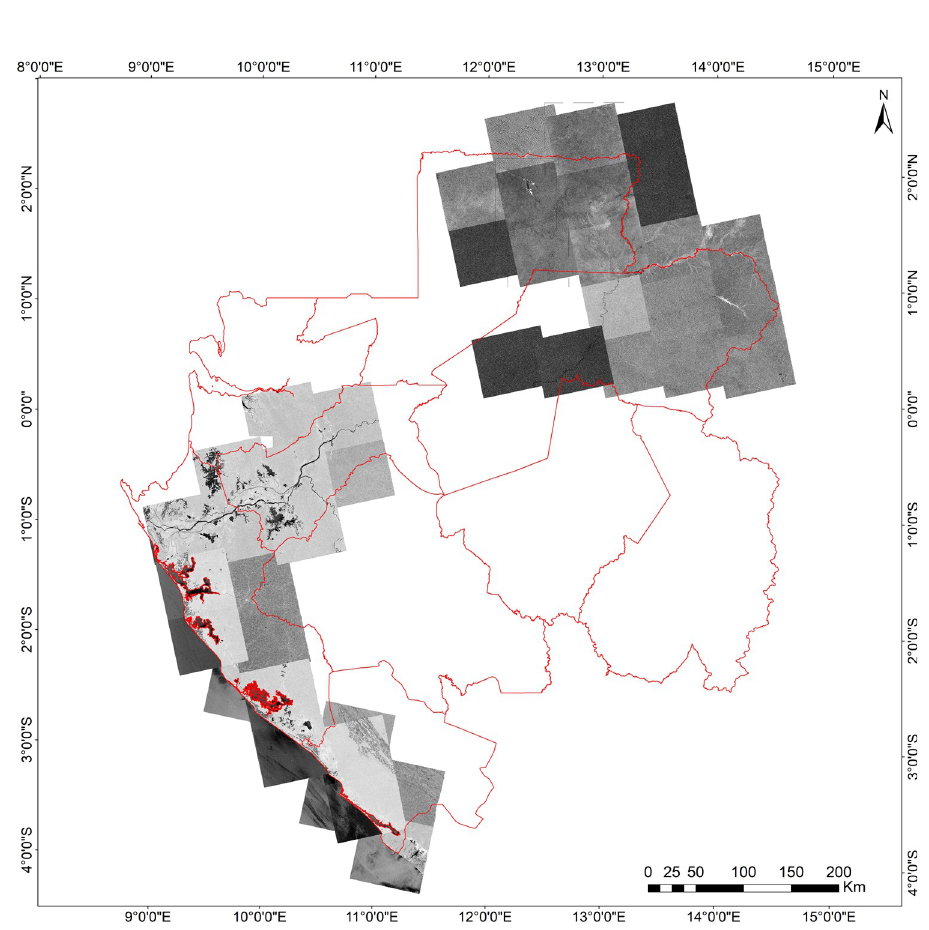
Fig 3. Advanced Land Observing Satellite-1 (ALOS) PALSAR’s L-band SAR imagery over northeast and south- southwest provinces. Available images over Gabon for the dry and rainy seasons of the years of 2008 and 2009 were